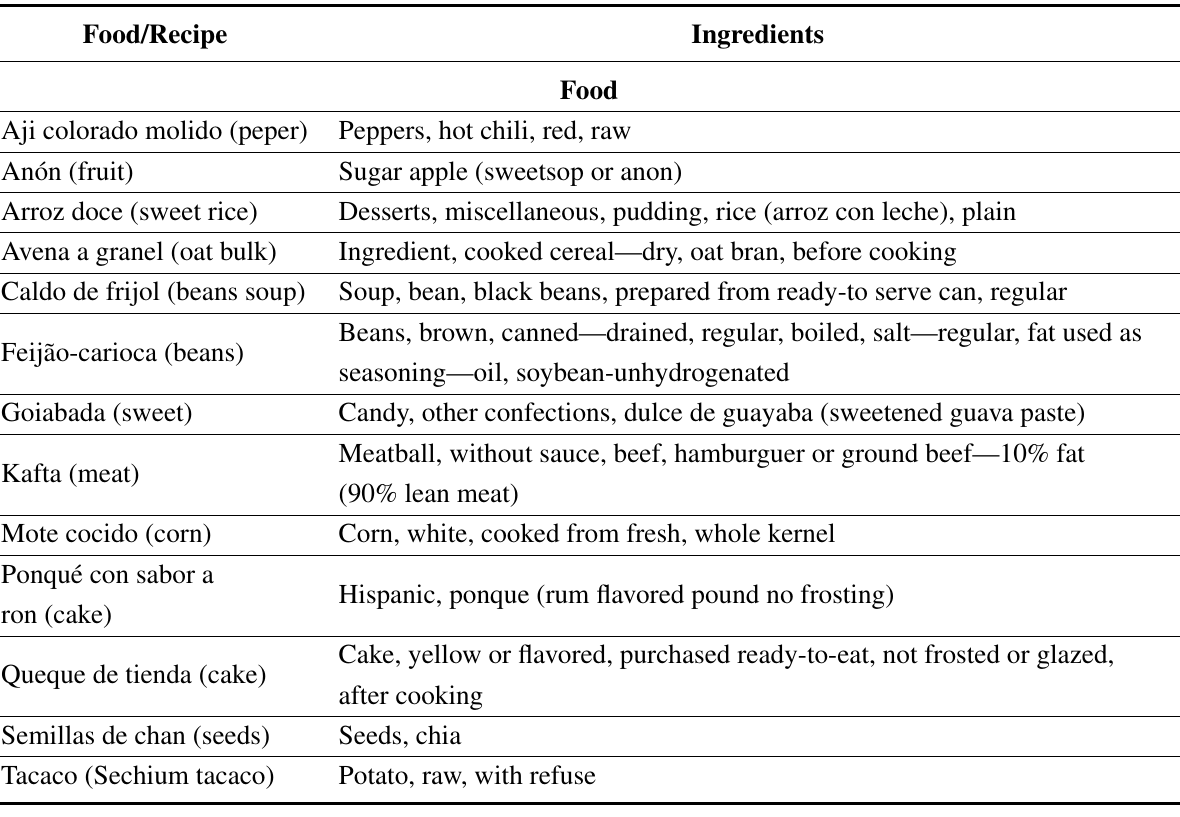
Table 3. Examples of food matching and recipes created in NDS-R for